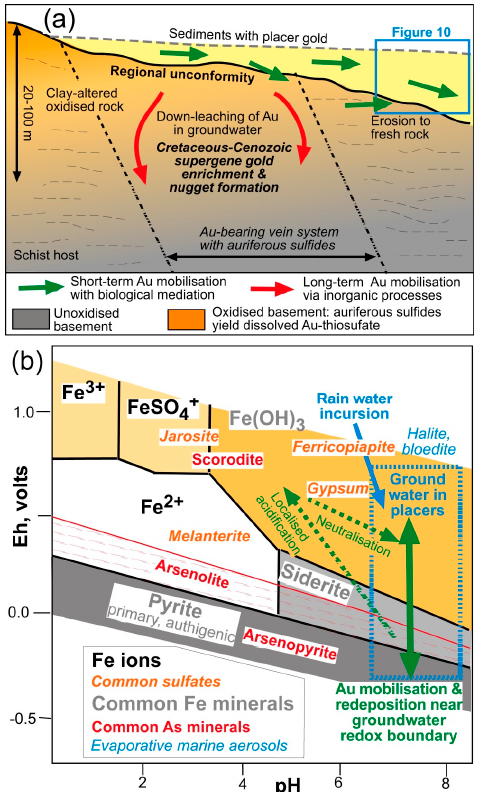
Figure 2. Summaries of principal geological, geochemical, and mineralogical features of near-surface gold mobility and redeposition within the Otago rain shadow. ( a ) Sketch cross section through the regional unconformity groundwater alteration zone in which long-term supergene gold enrichment has occurred to form nuggets since the Cretaceous. A sedimentary veneer has short-term gold mobility that is at least partially biologically mediated and is the focus of this study; ( b ) Sketch Eh-pH diagram, summarised from Geochemists Workbench modelling, showing the pH and redox relationships among minerals found within the placer gold sediments and basement, as outlined in this study.